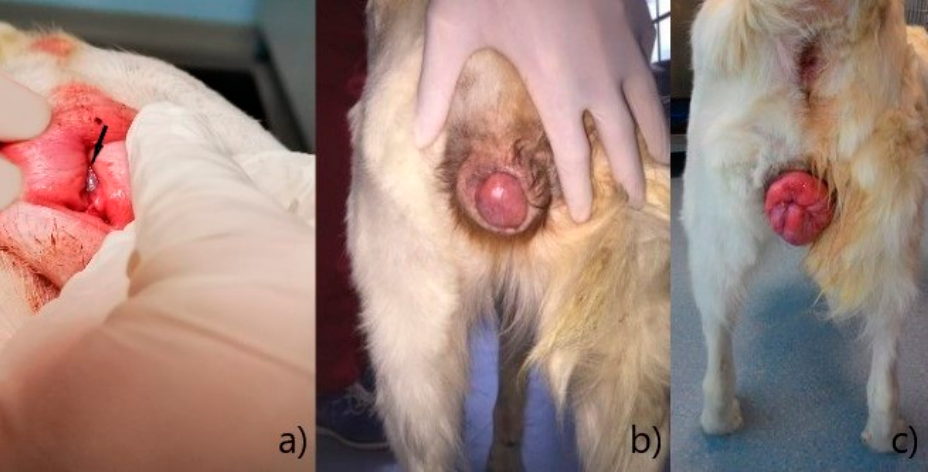
Figure 1 . Degrees of vaginal hyperplasia [4]: ( a ) Type I, vaginal hyperplasia is indicated by an arrow; ( b ) Type II; ( c ) Type III .